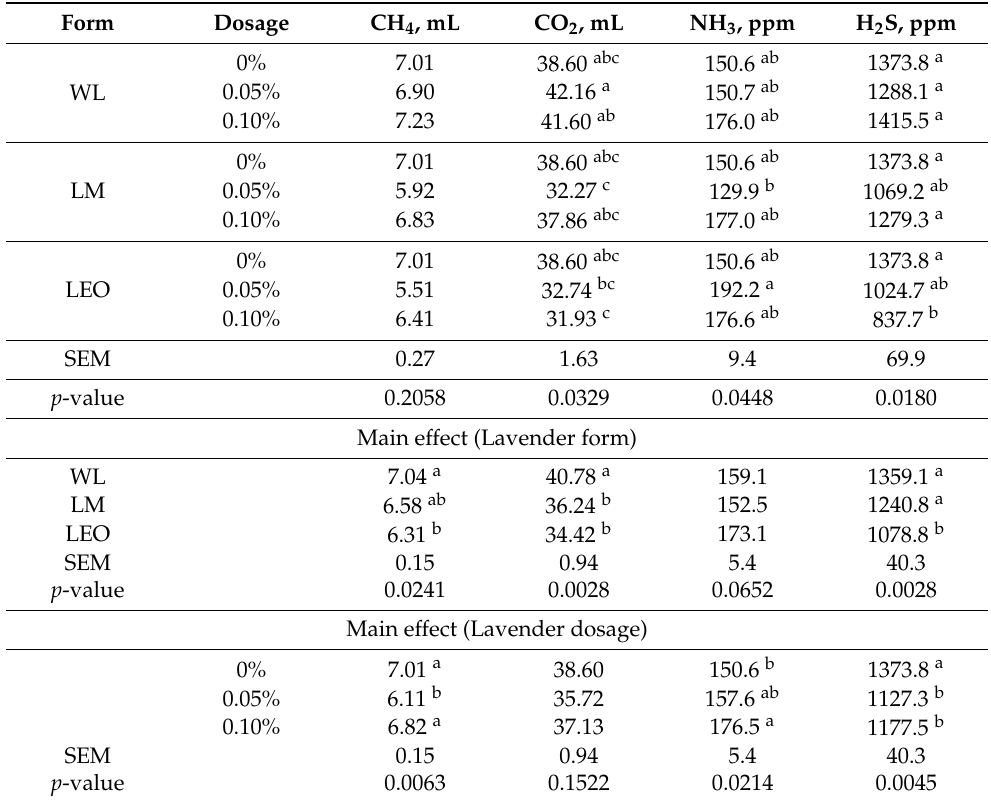
Table 5. The effects of different doses and forms of lavender on the formation of gases in vitro.